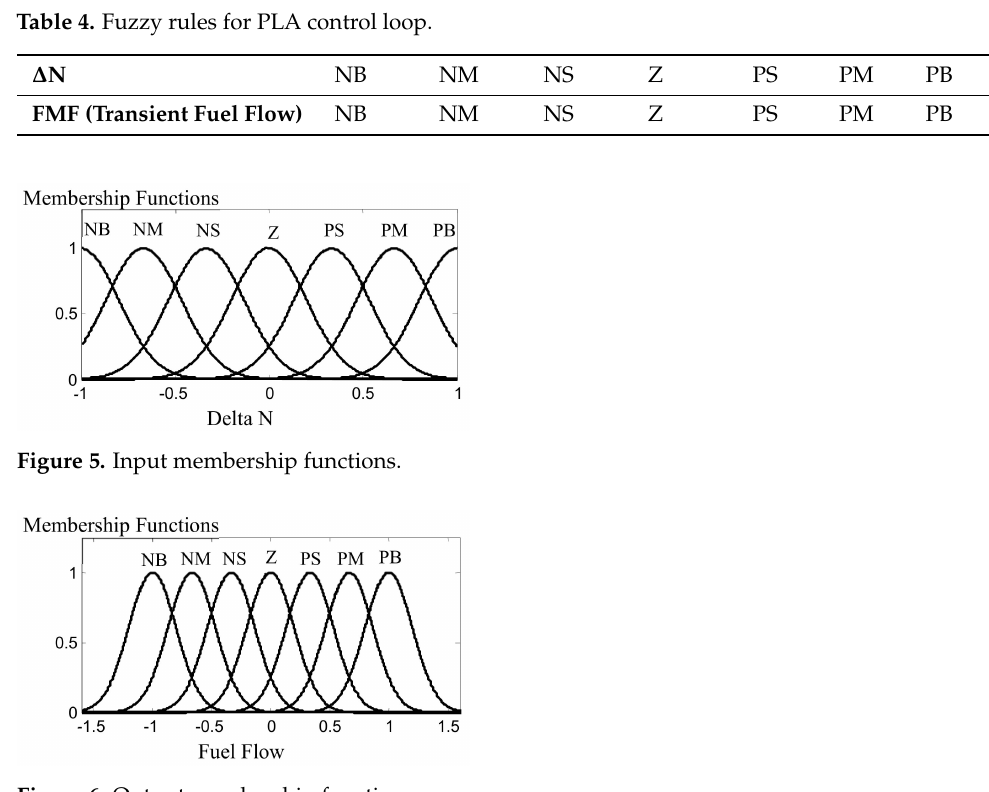
Figure 6. Output membership